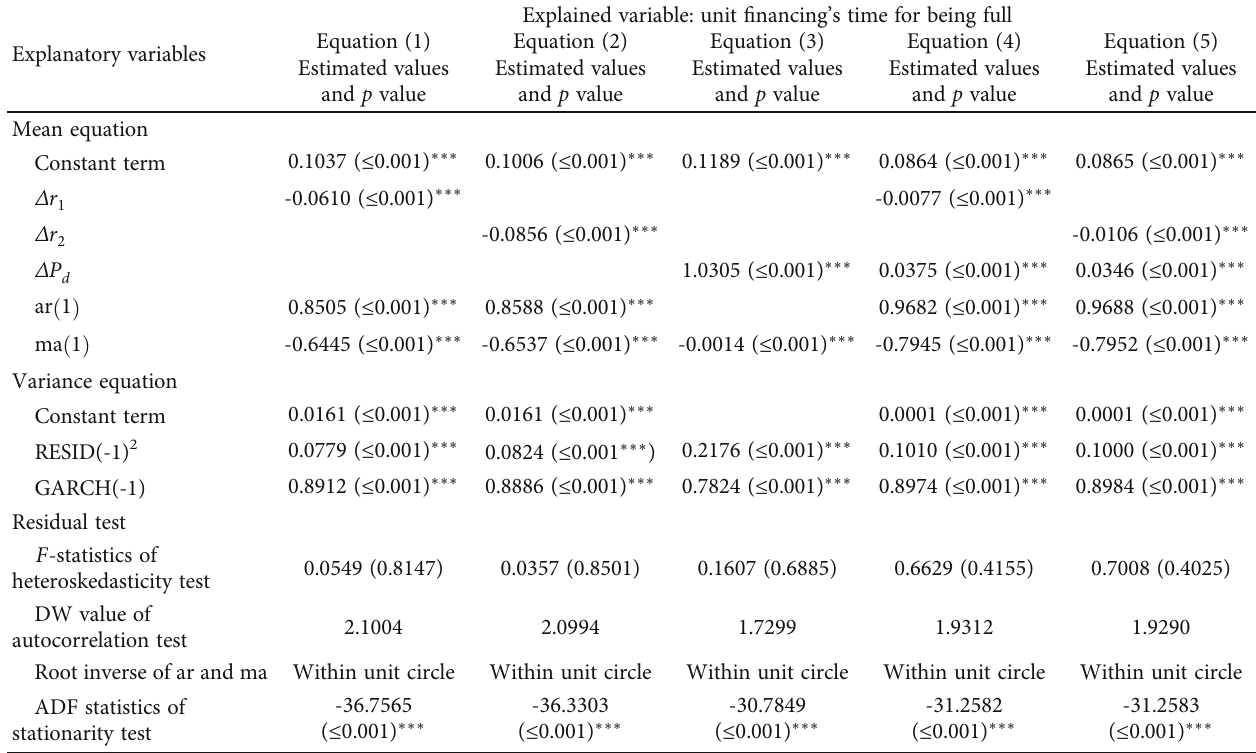
Table 6: Regression results to time for being